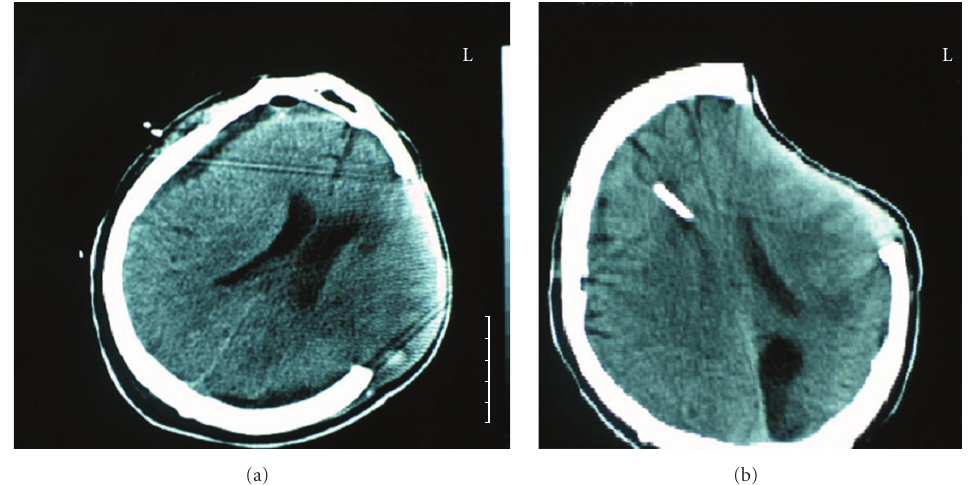
Figure 2: Postcraniectomy SDEH with bulging of the brain through the craniectomy defect (a) which is resolved after the treatment of hydrocephalus with a V-P